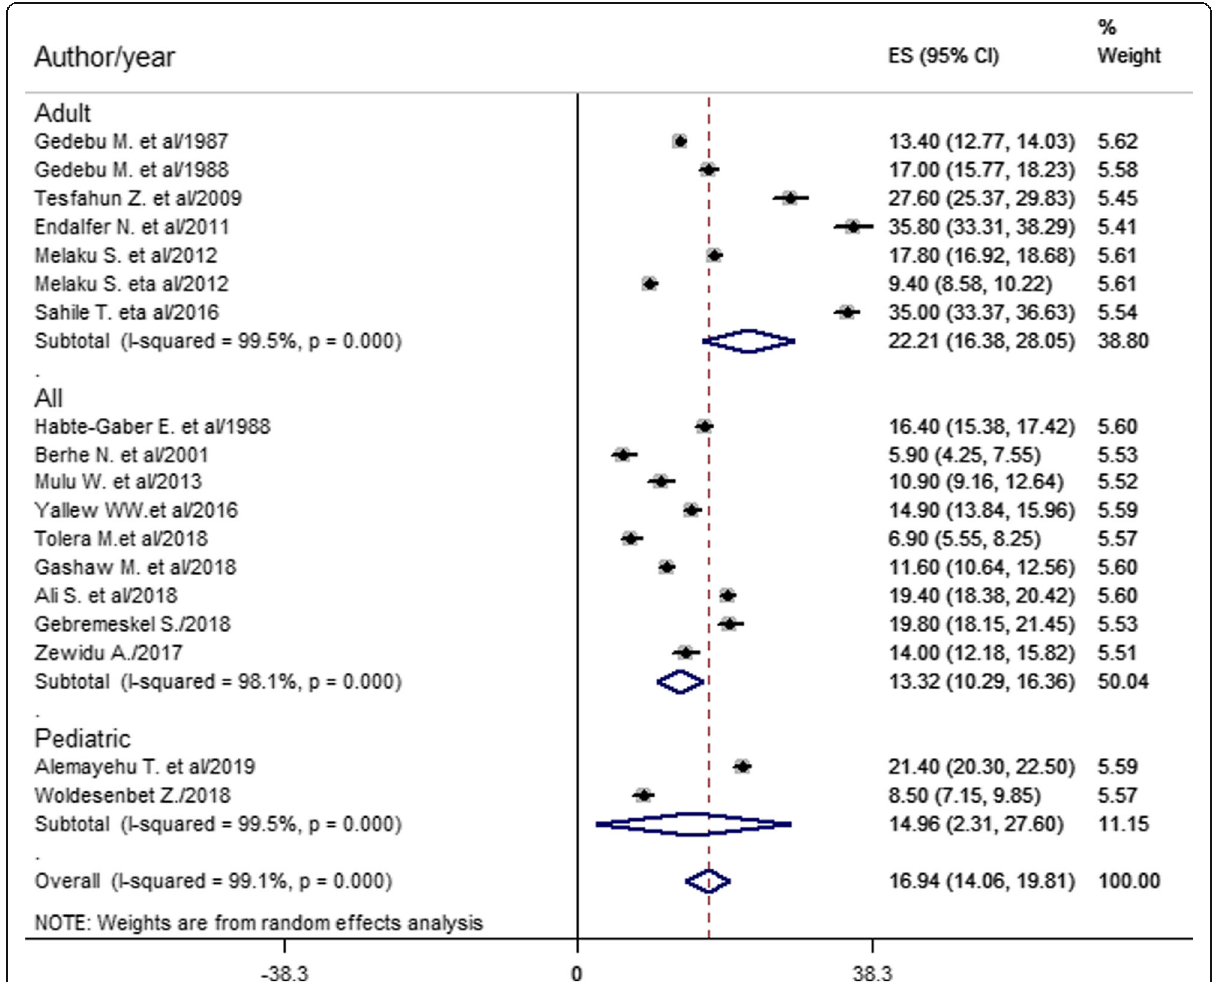
Fig. 5 Forest plot of prevalence with corresponding 95% CIs of HCAI based on study